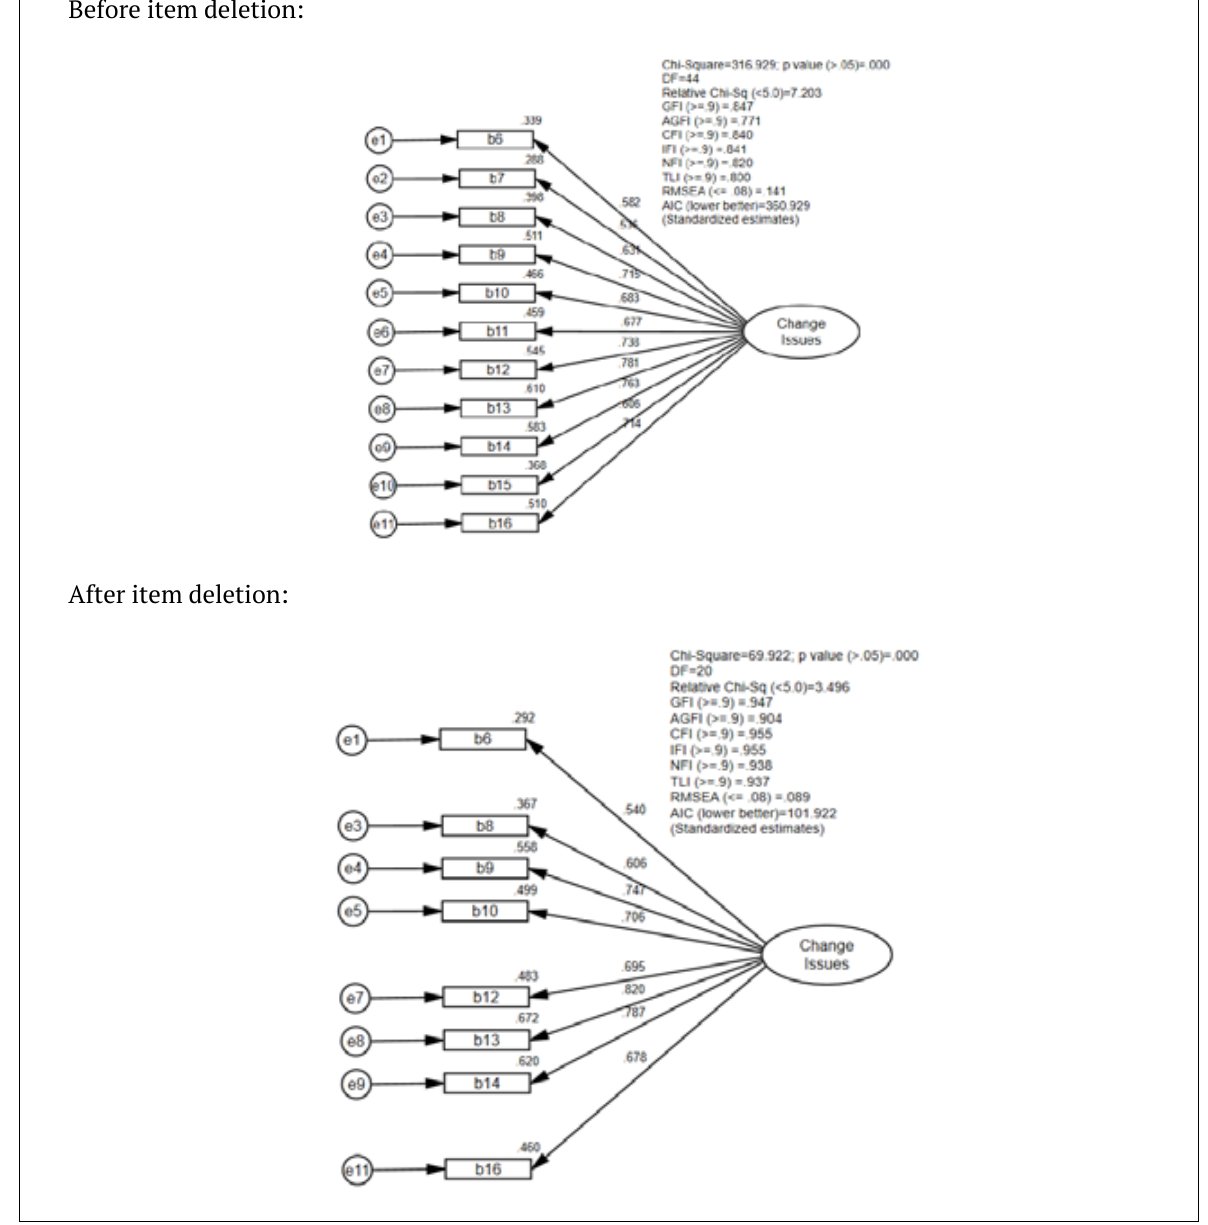
Figure 2. Confirmatory Factor Analysis for Change Issues